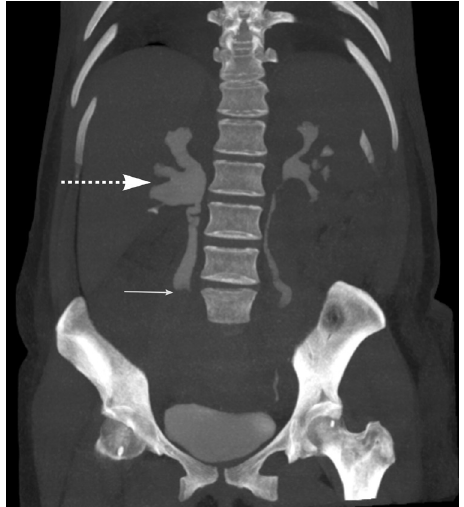
Figure 3 - A computed tomographic image that depicts the obstruction of the right ureter (thin arrow) by the enlarged right ovarian vein (thick dashed arrow).